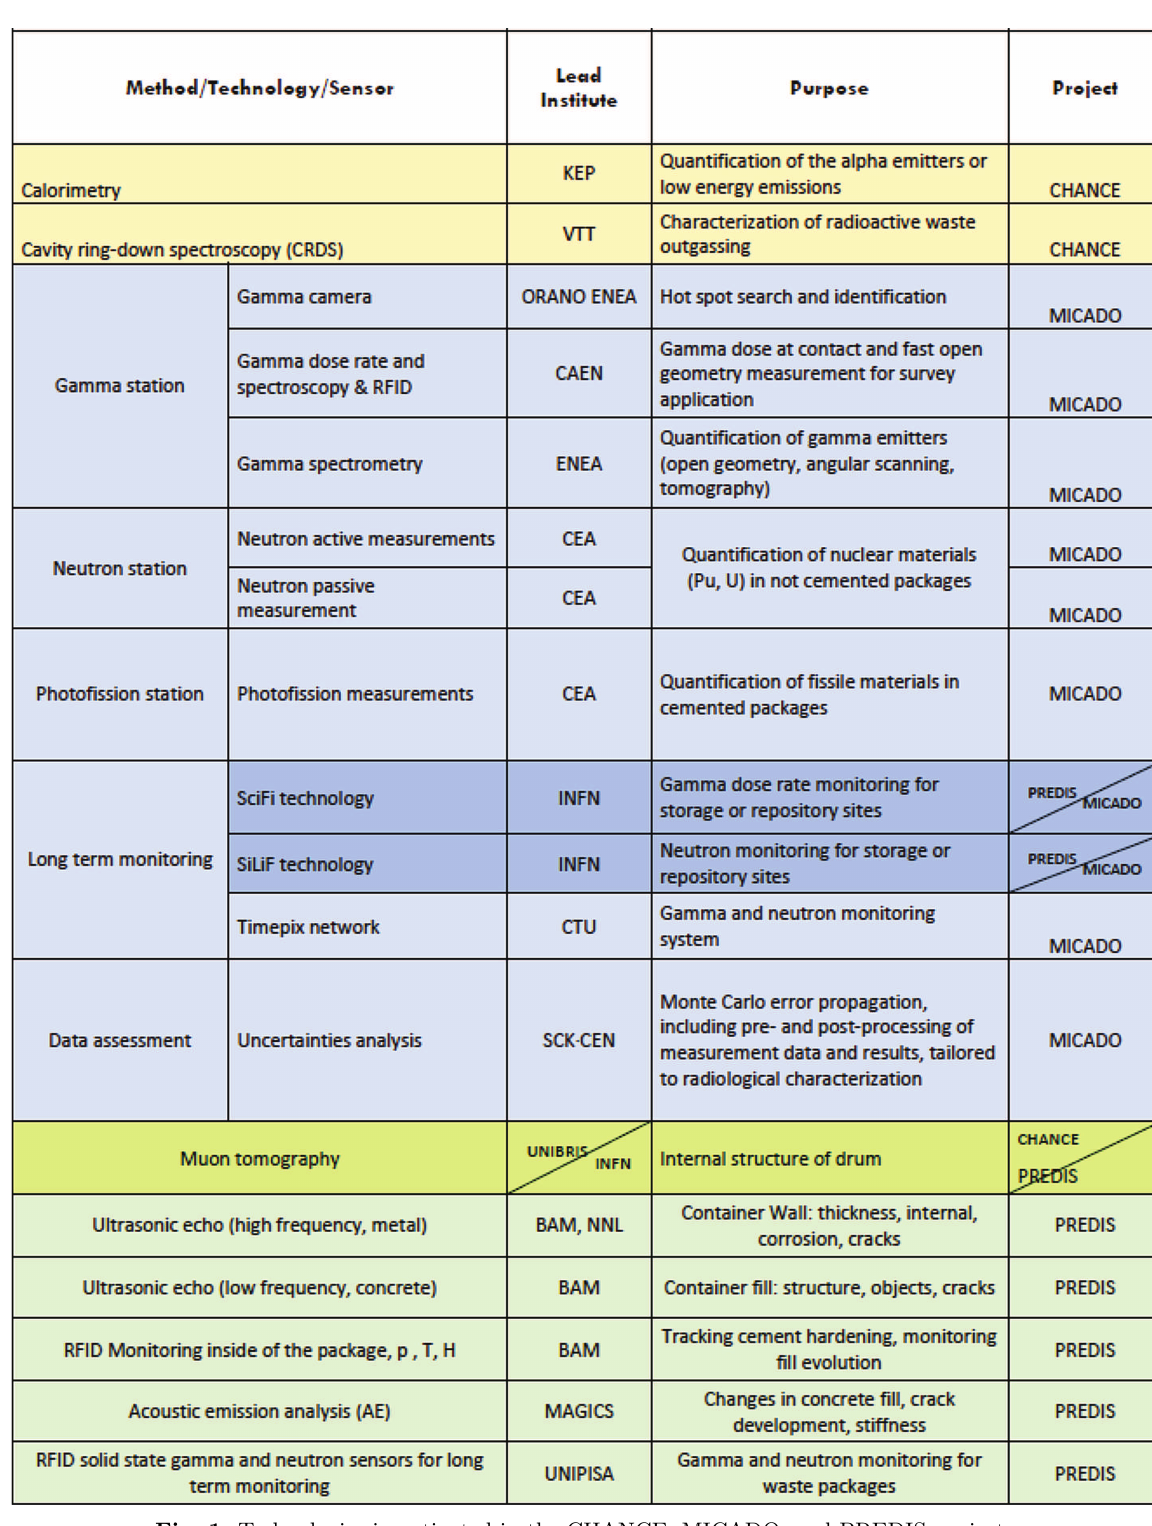
Fig. 1. Technologies investigated in the CHANCE, MICADO, and PREDIS